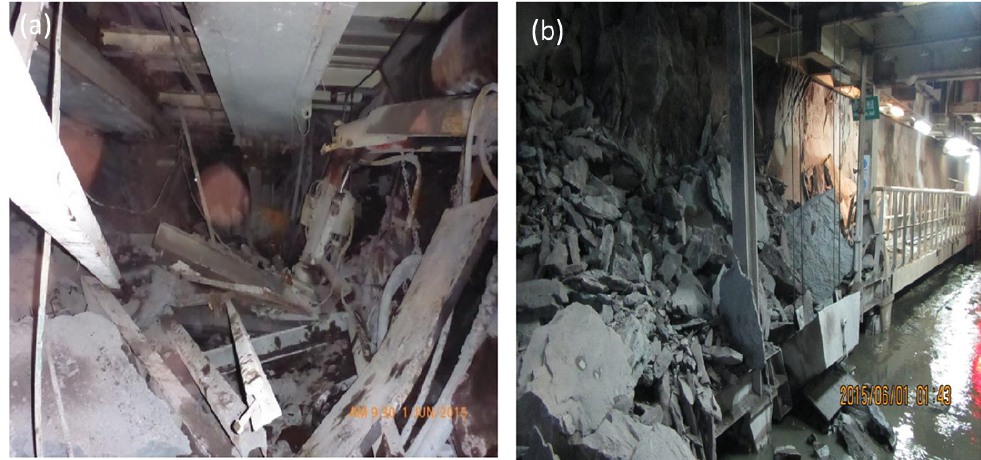
Figure 17. ( a ) Rock burst; and ( b ) caused damage around the steel rib in NeJHP (Source: Naji et al.